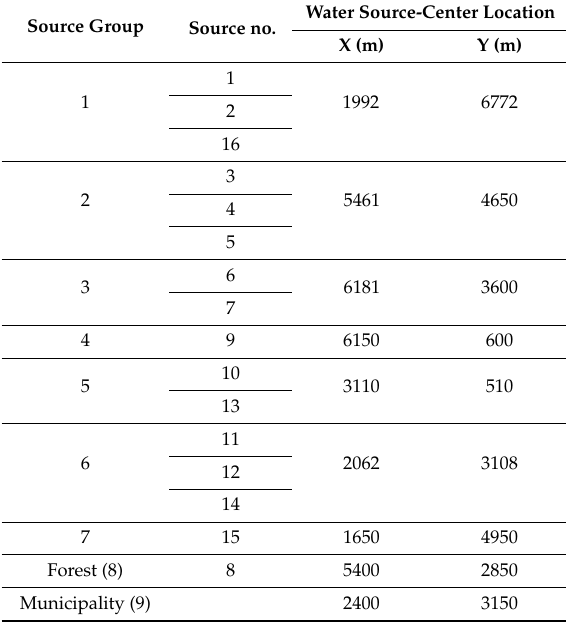
Figure 7. ( a ) Available water sources and their groups; ( b ) Water-source centers (based on minimized Euclidean distance). Table 1. Source groups and location of source centers.